Question: How would you classify this visualization?
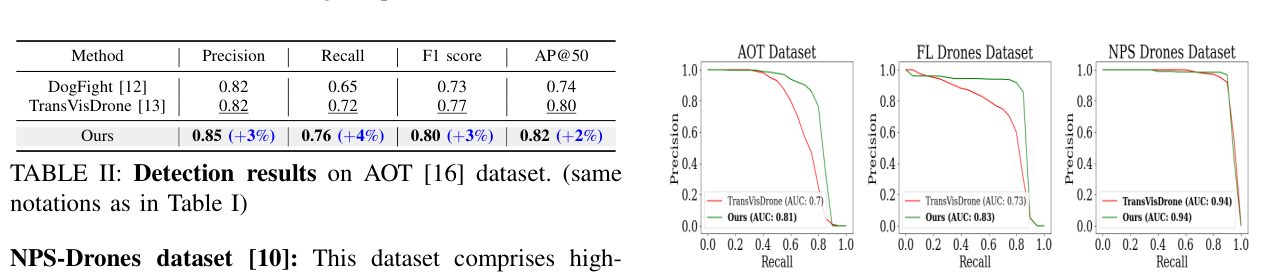
Answer: line